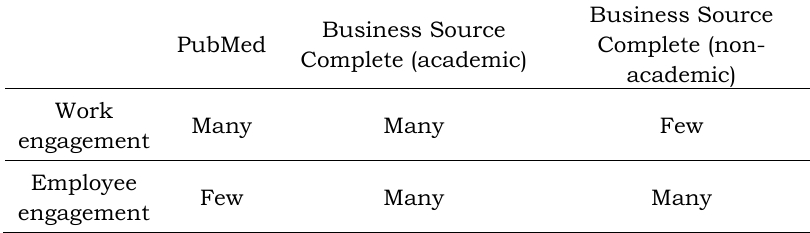
Table 1. WE and EE in different